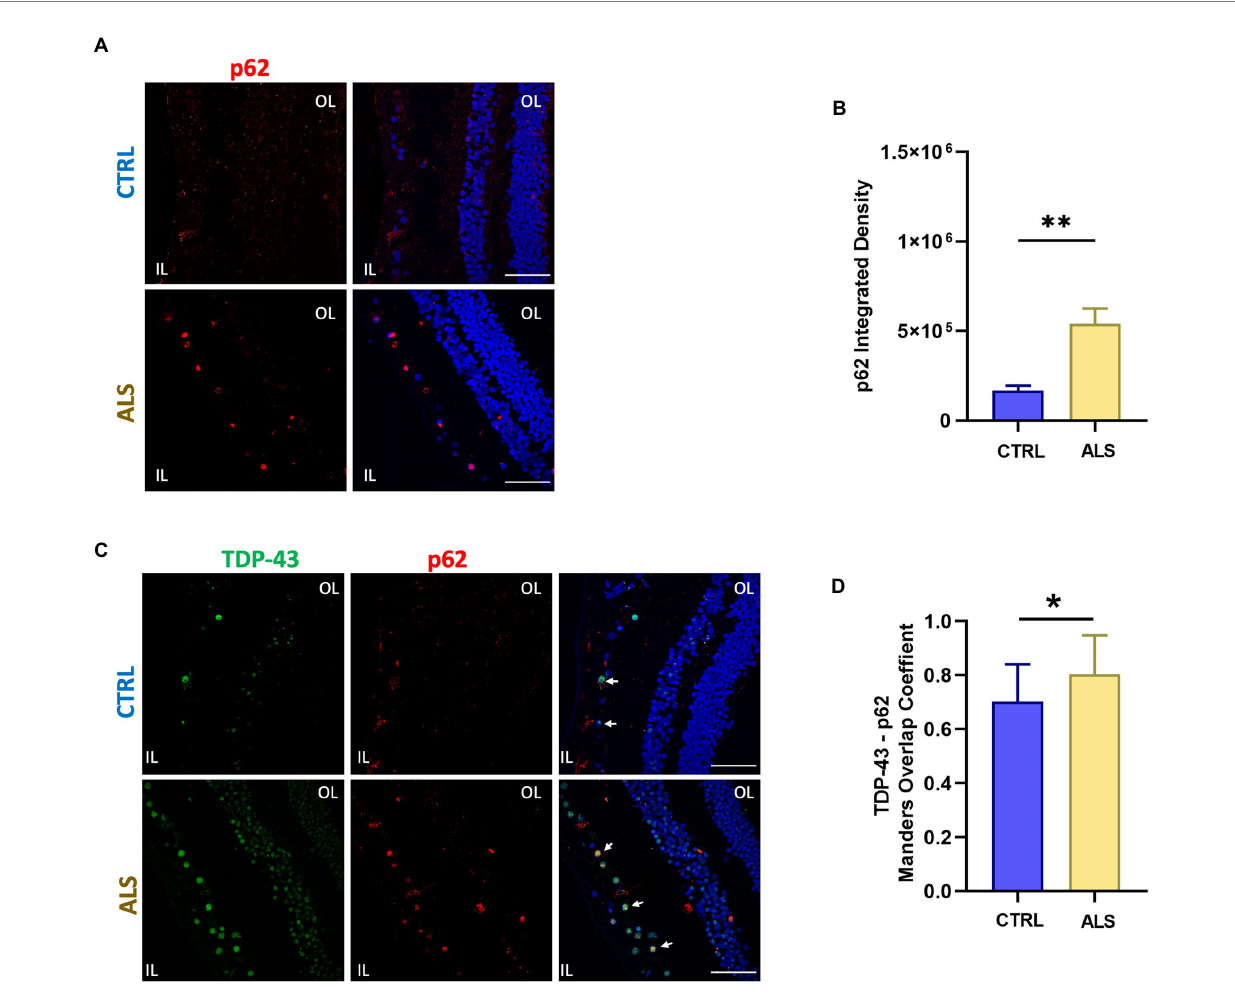
FIGURE 2 SQSTM1/p62 aggregates accumulate in the human ALS retina. (A) Representative immunofluorescence images of anti-p62 staining (red) on human retinal slices from ALS patients and healthy controls. Hoechst was used to stain nuclei (blue); scale bar 50 μ m. (B) Bar chart showing the quantification of p62 aggregates accomplished by integrated density/field of view ( ** p < 0.01 ALS vs. CTRL; Mann–Whitney U test; ALS n = 59/7 fields/individuals; CTRL n = 65/6 fields/individuals). (C) Representative immunostaining of TDP-43 (green) and p62 (red) in human retinal slices. Arrows indicate co-localized signals. (D) Bar graphs representing the co-localization of p62 and TDP-43 positive inclusions in ALS retinal slices calculated using Manders overlap coefficient (ALS: n = 17/4; CLTR: 14/4 fields/individuals; * p <